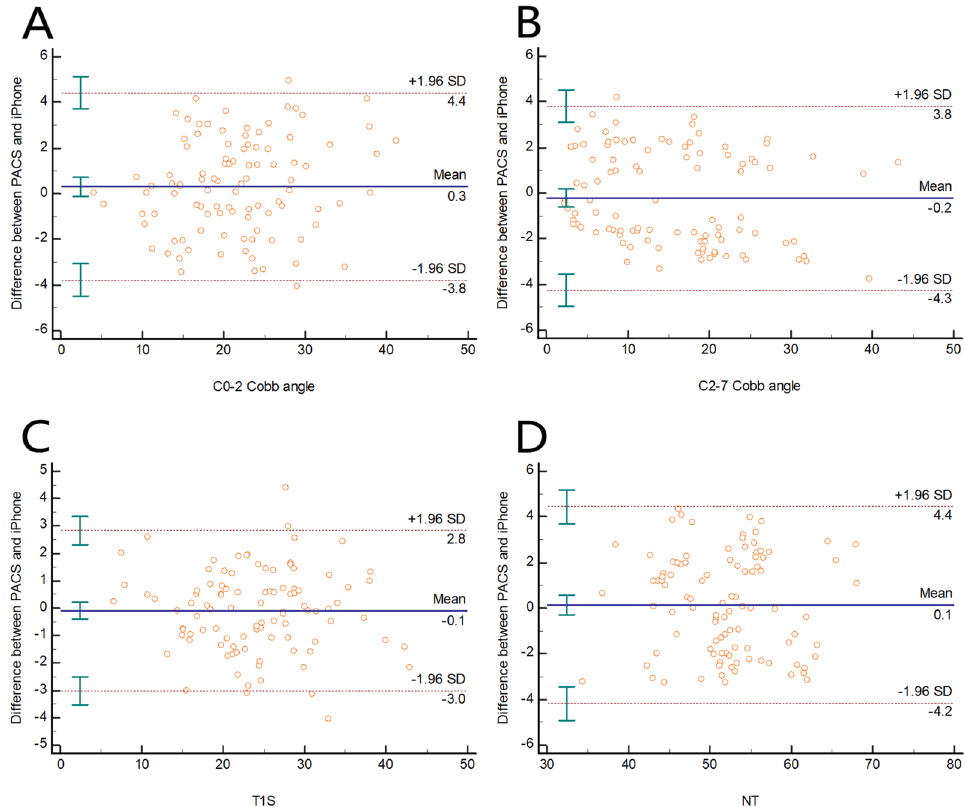
Figure 3. Bland ‒ Altman plot revealing the difference between the PACS and iPhone measurements for the ( A ) C0-2 Cobb angle, ( B ) C2-7 Cobb angle, ( C ) T1S, and ( D ) NT. The mean difference is shown as the solid lines in the middle, and the 95% CI is presented as the outer two dotted